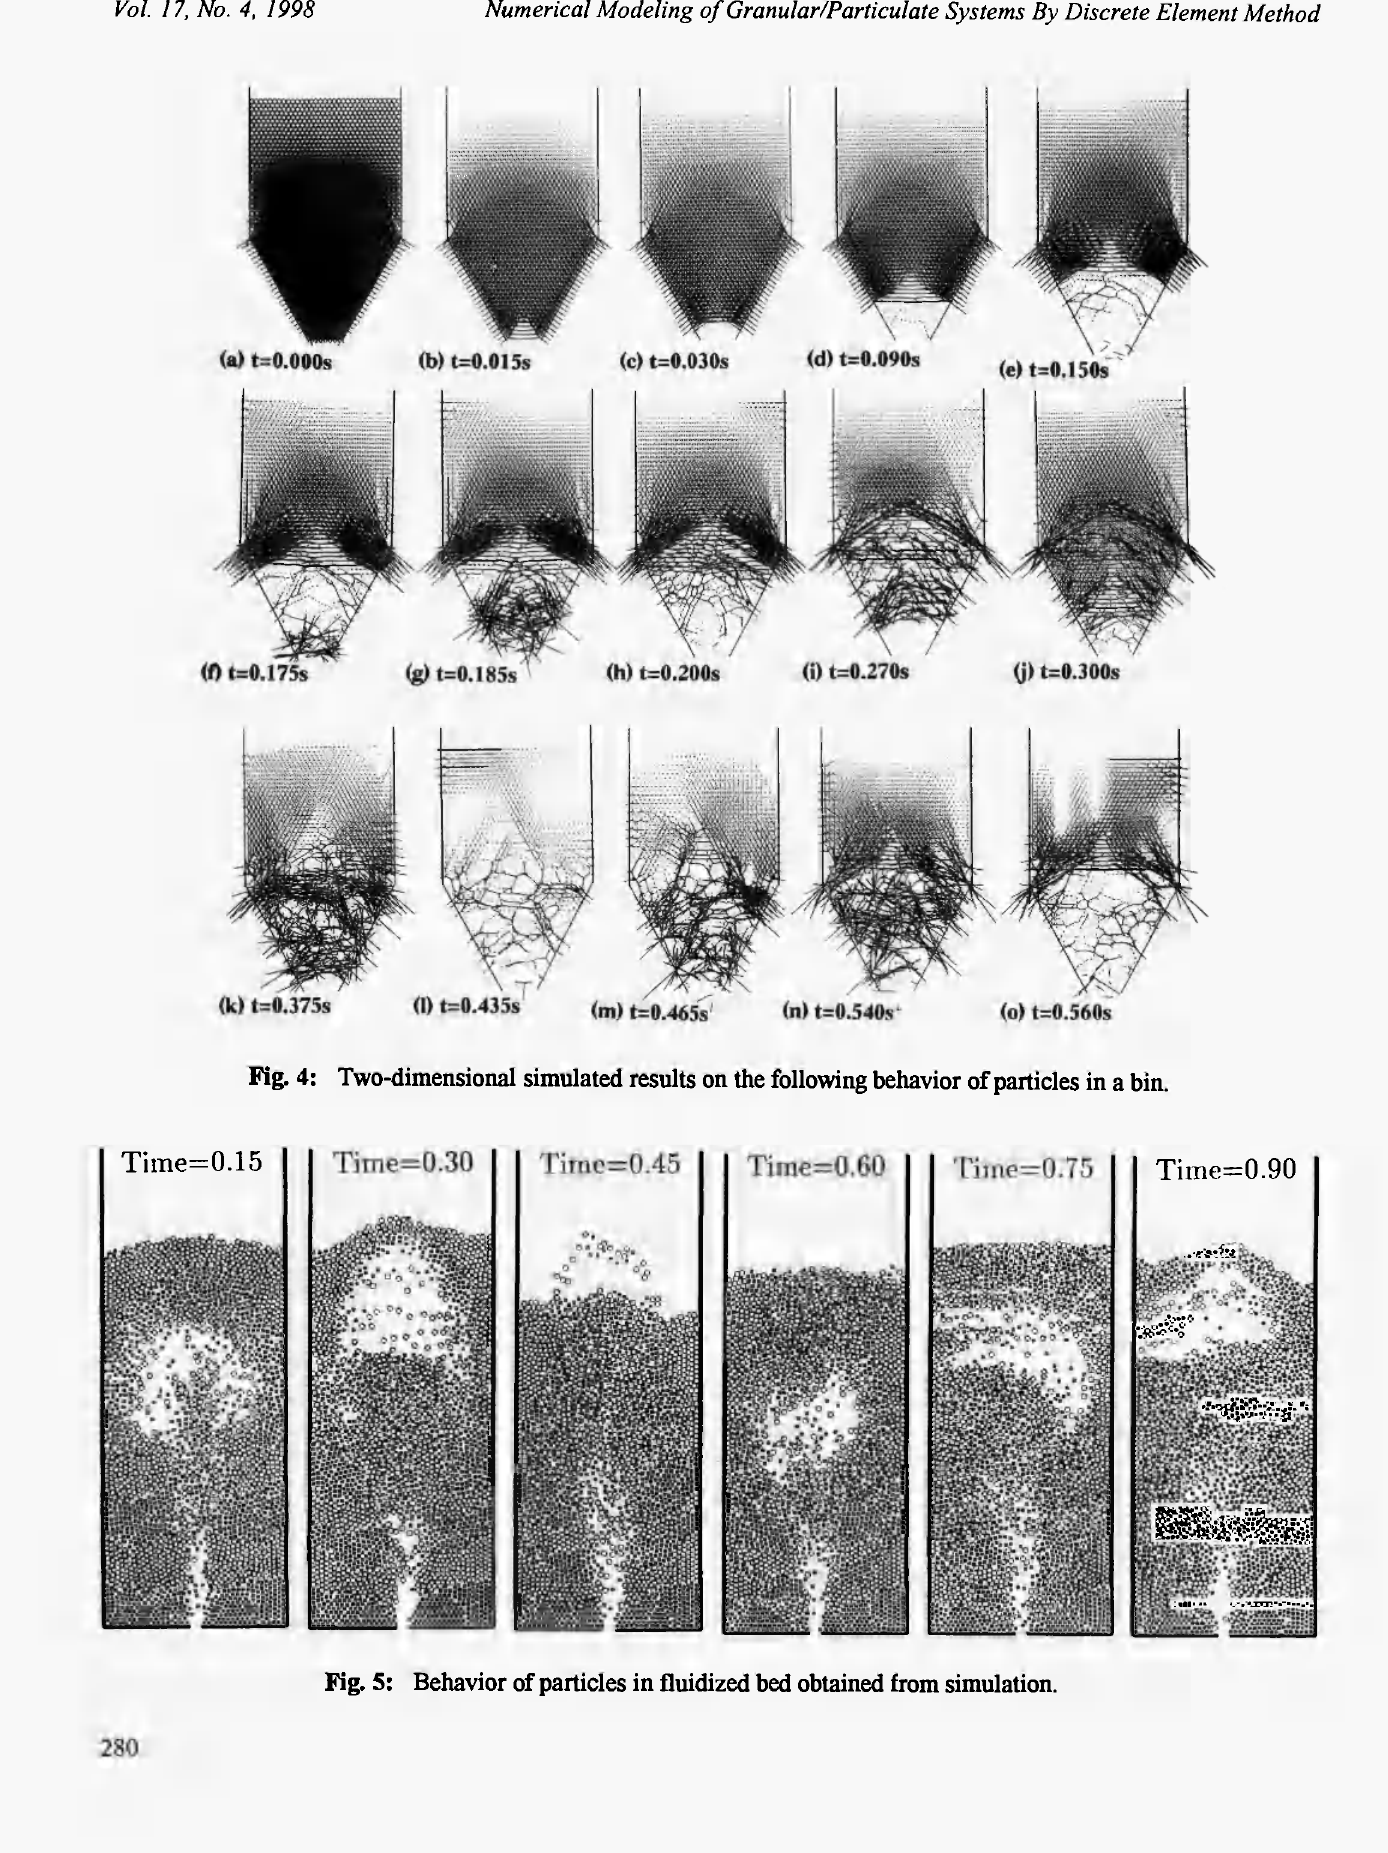
Fig. 4: Two-dimensional simulated results on the following behavior of particles in a bin. Time=0.15 Time=0.90